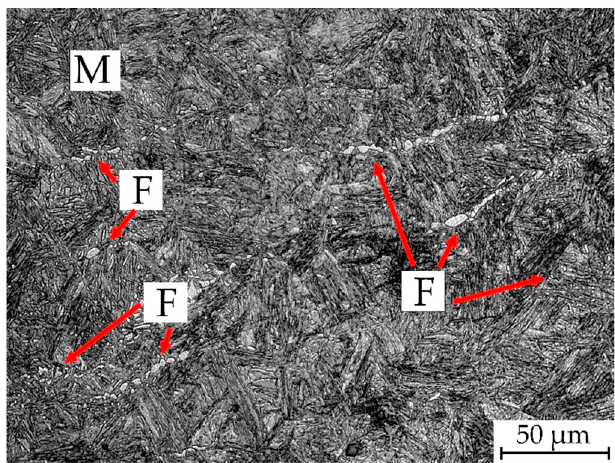
Figure 7. Microstructure of the sample quenched directly after deformation.